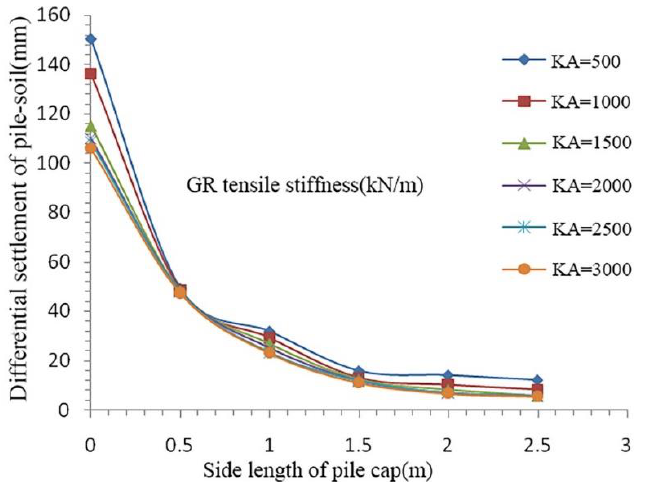
Figure 12. Differential settlement of pile soil with different pile cap sizes and GR tensile stiffness values.